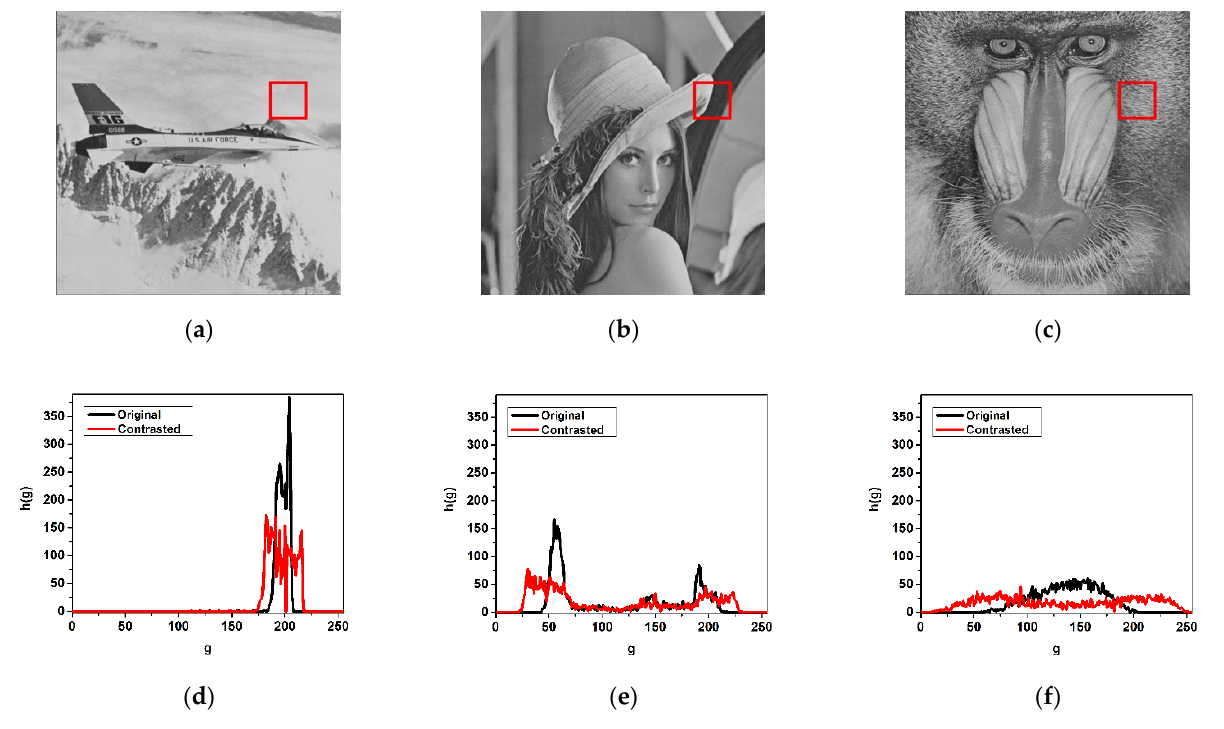
Figure 10. Original images: ( a ) F-16; ( b ) Lena; ( c ) Baboon with a selected block (red square); ( d – f ) original histogram (black line) and enhanced histogram (red line) of the selected block.